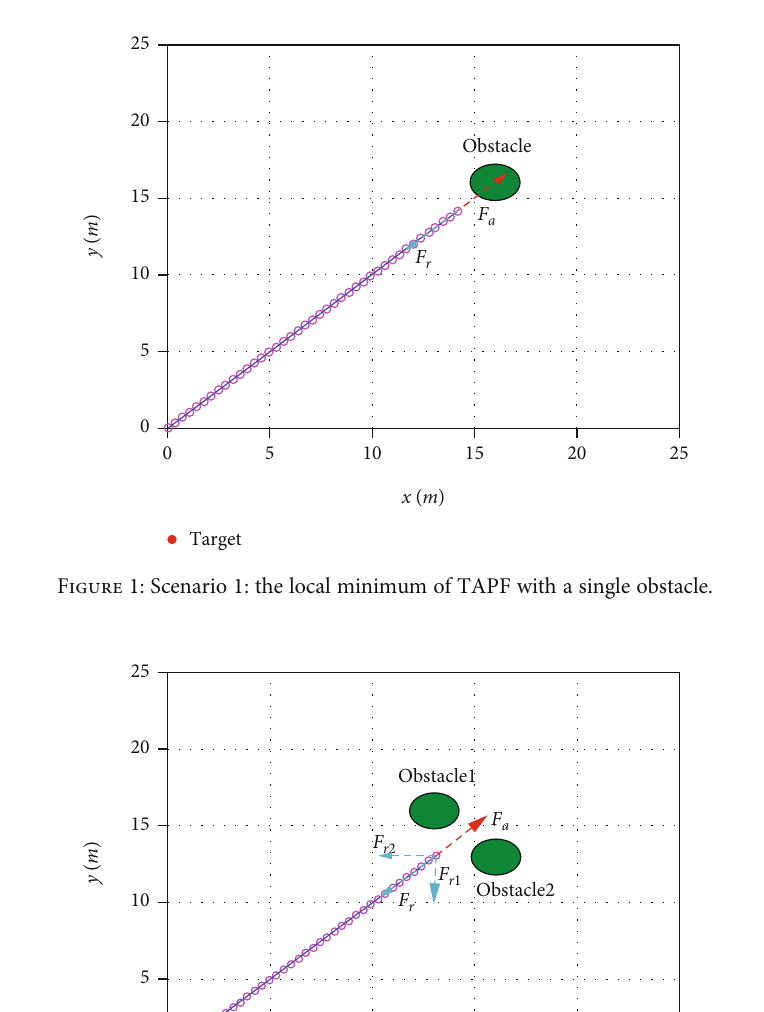
Algorithm 1: Path planning algorithm based on TAPF